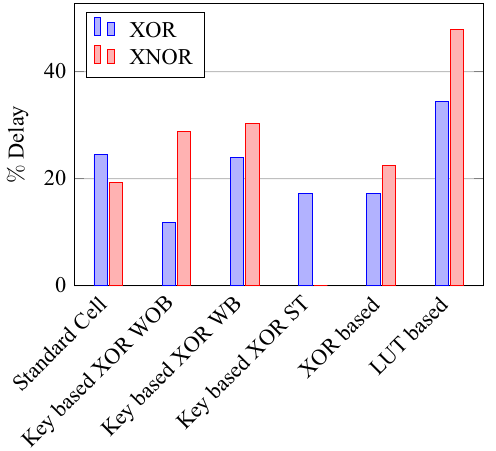
Figure 45. % of Change in delay for XOR & XNOR gates compared to proposed design.